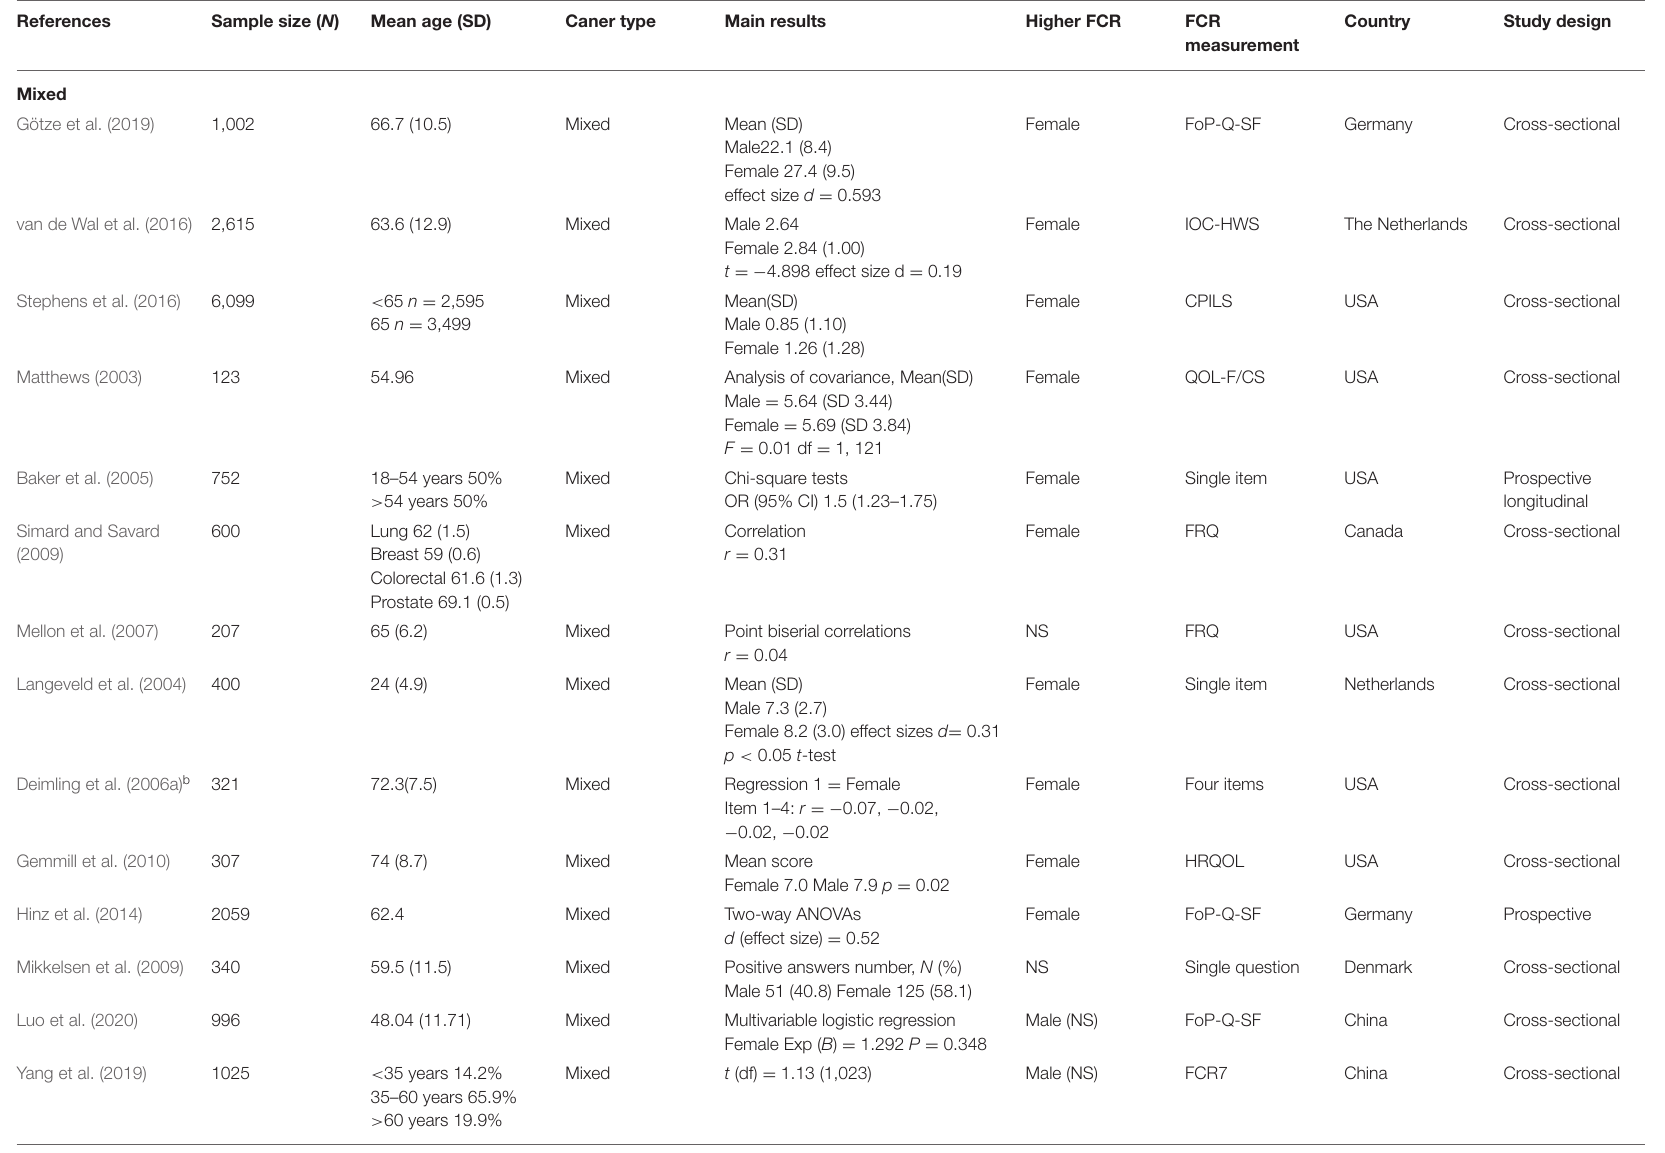
TABLE 1B | Summary characteristics of the included studies in mixed